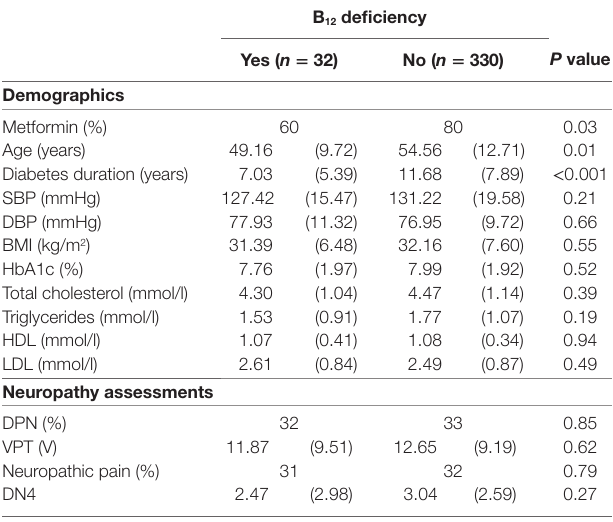
TaBle 2 | Comparison of demographic and clinical characteristics between those with (serum B 12 < 133 pmol/l) and without B 12 deficiency.